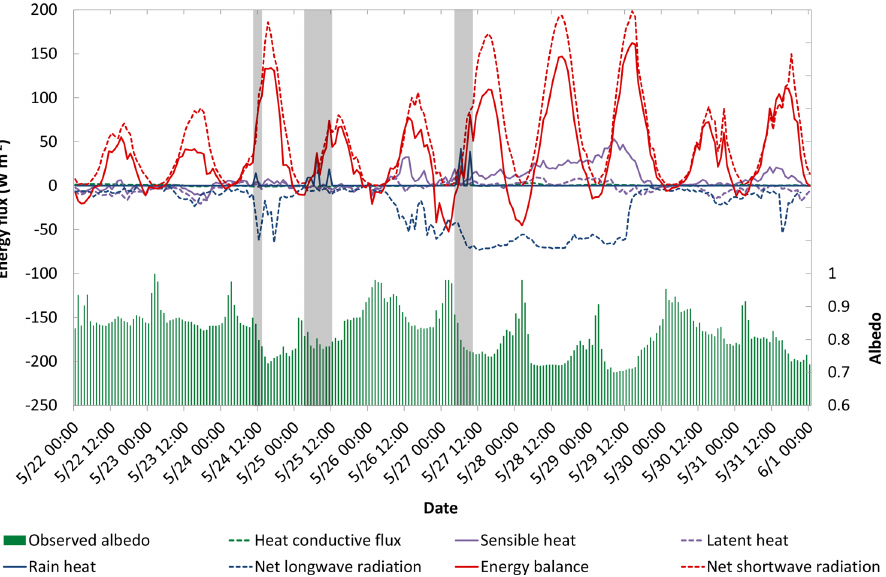
Figure 3. Energy balance of snow over sea ice during the early stage of melt season. Observed net solar radiation, albedo, net longwave radiation and timing of rainfall from 22 May through 1 June 2017 (local time). Calculated sensible heat, latent heat, heat conductive flux and energy budget during the same period are also shown. Rain heat includes the heat that rain directly brings into the snowpack and the latent heat release when the rain freezes within the snowpack. Grey shading shows the timing of rainfall.